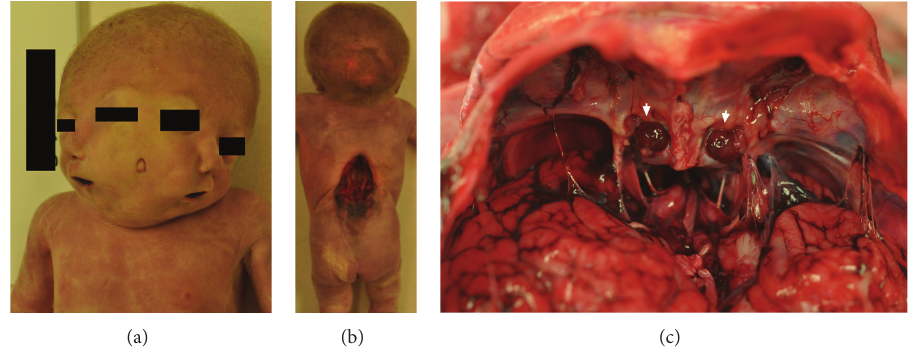
Figure 2: (a) Facial duplication with a hypoplastic pinna in the midline. (b) Open thoracolumbar myelomeningocele measuring 6.3 cm × 3.9 cm. (c) Anterior cranial fossa with two pituitary glands (white arrows).